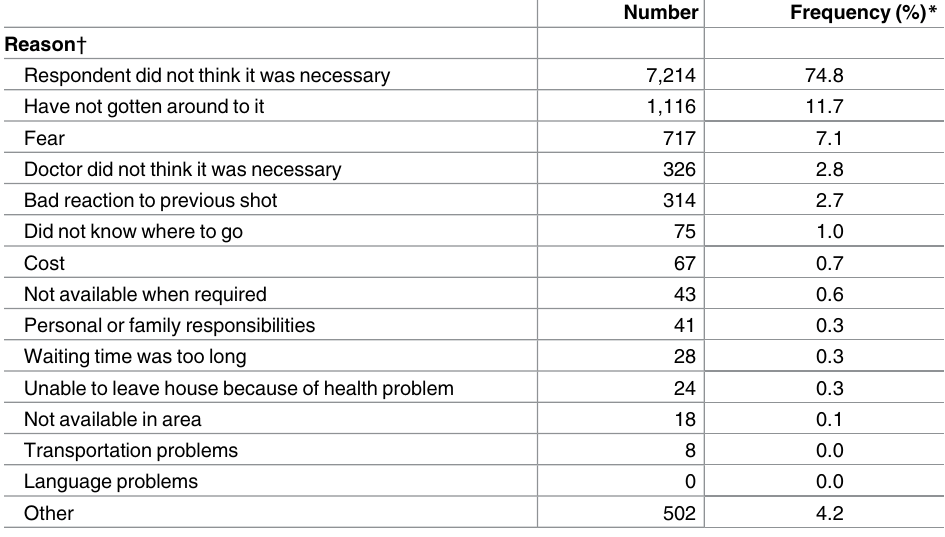
Table 2. Reasons for non-vaccination in adults (aged 18–64)with asthma who have never had a flu shot ( n = 9,836).